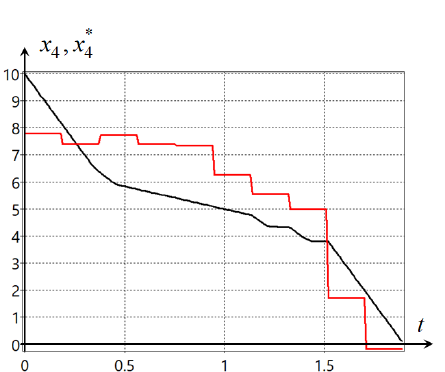
Figure A4. Plots of optimal x 4 and x 4 ∗ .